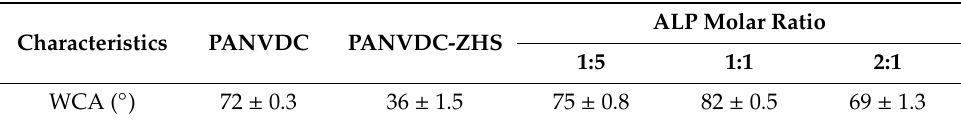
Table 1. WCA of PANVDC, ZHS-PANVDC, and PANVDC films with ALP-ZHS composites prepared by different ALP molar ratios (1:5, 1:1, and 2:1) at 50 ˚ C for 1.5 h. Characteristics